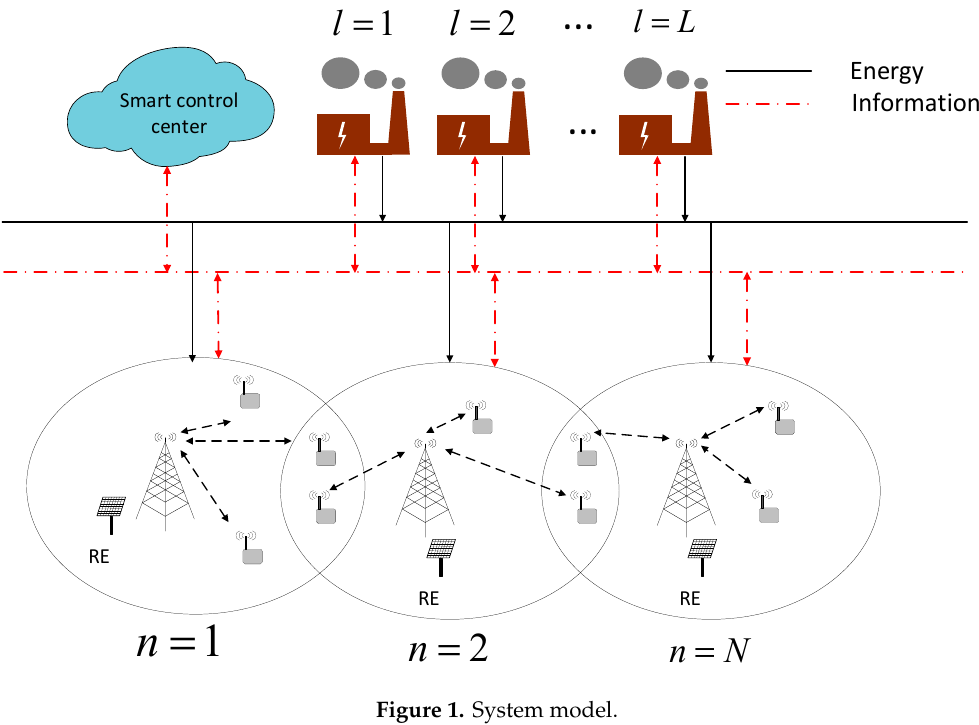
Figure 1. System model.